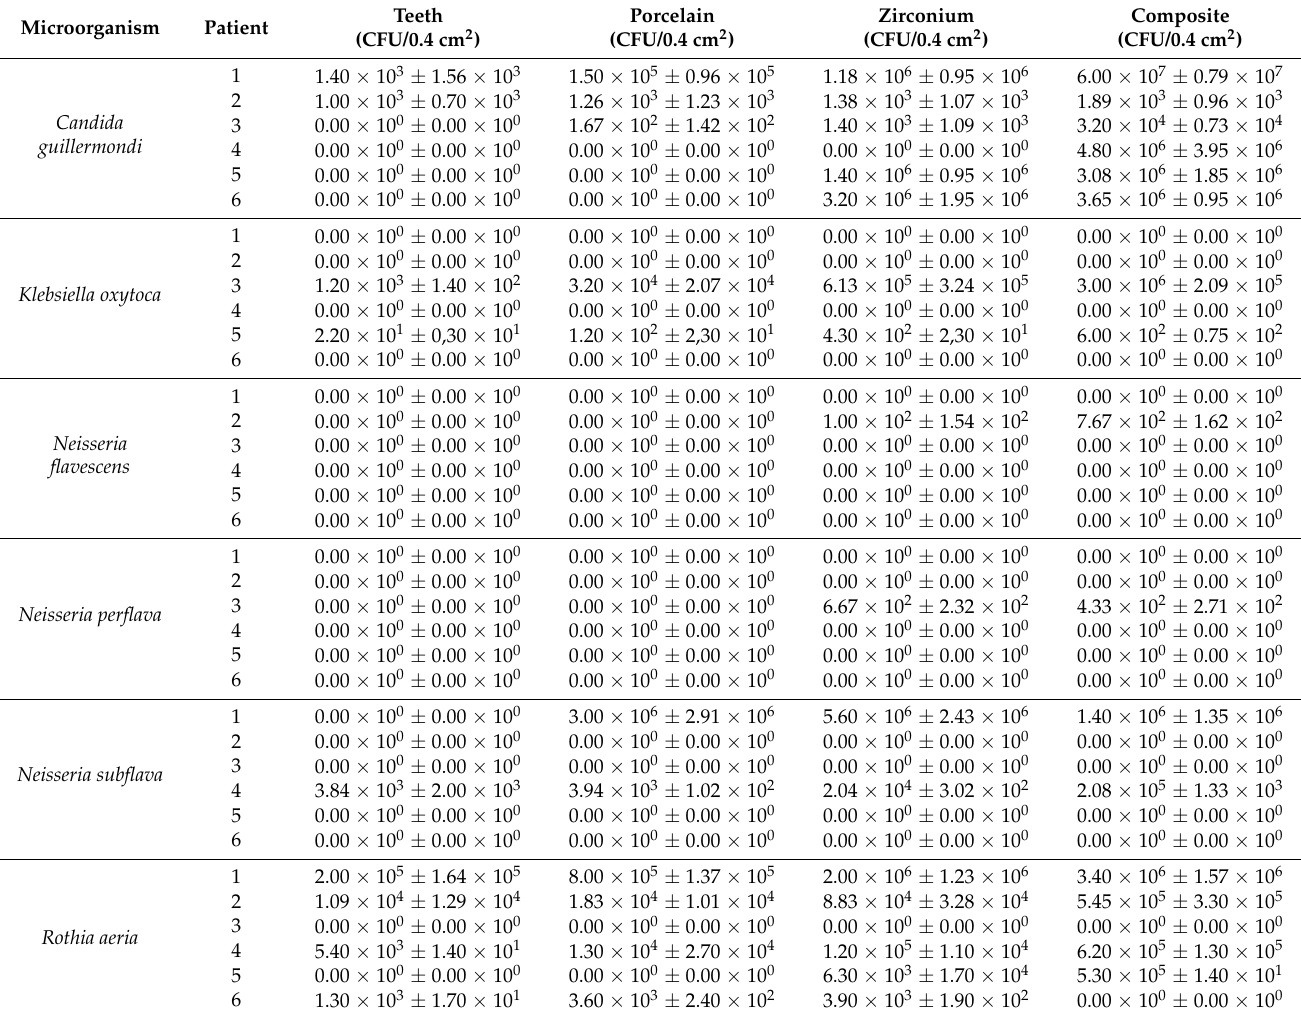
Table 2. The average number of microorganisms identified using the MALDI–TOF MS technique on the surface of the composite, zirconium, porcelain, and tooth crown in Patients